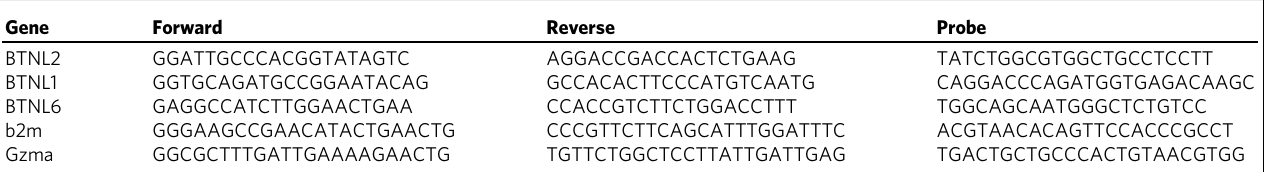
Table 1 RT-PCR Probes for select